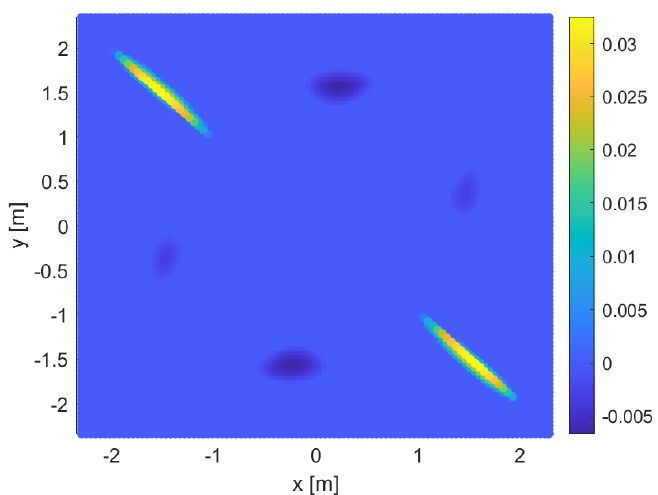
Figure 19. Colormap of g ( x 1 , x 2 ) for the case of the cross vault, after the first optimization phase. Yellow points represent regions of the domain for which the membrane is above the extrados. Blue points on the diagonal of the domain represent regions of the domain for which the membrane shape is below the